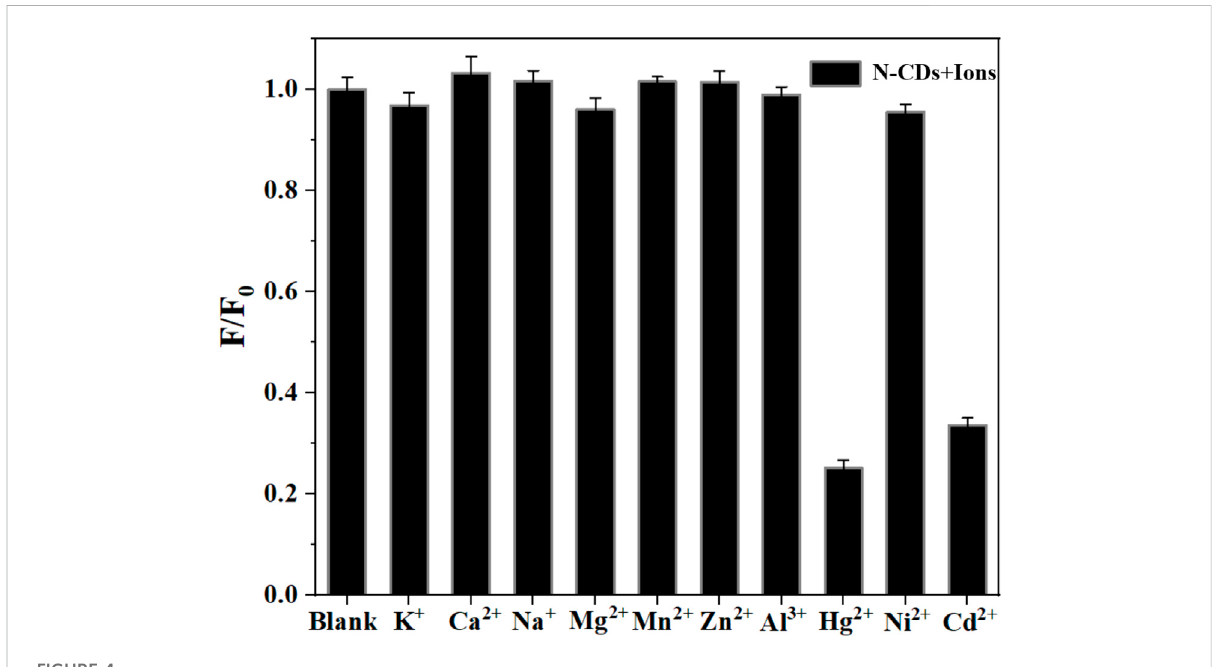
FIGURE 4 Selectivity of N-CDs toward different metal ions.